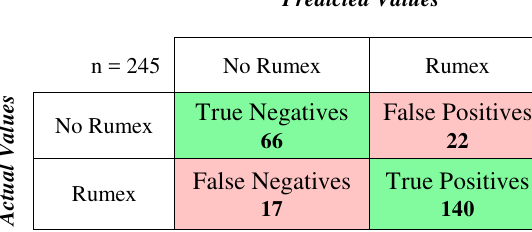
Figure 14. Confusion Matrix – Classification using the partly cut off trained model.